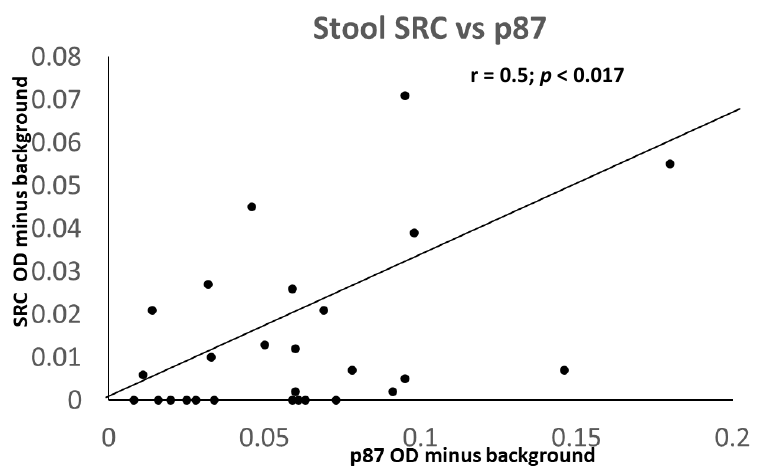
Figure 17. A Scattergram showing a positive correlation of Src and Adnab-9-defined p87 in the infant stool.